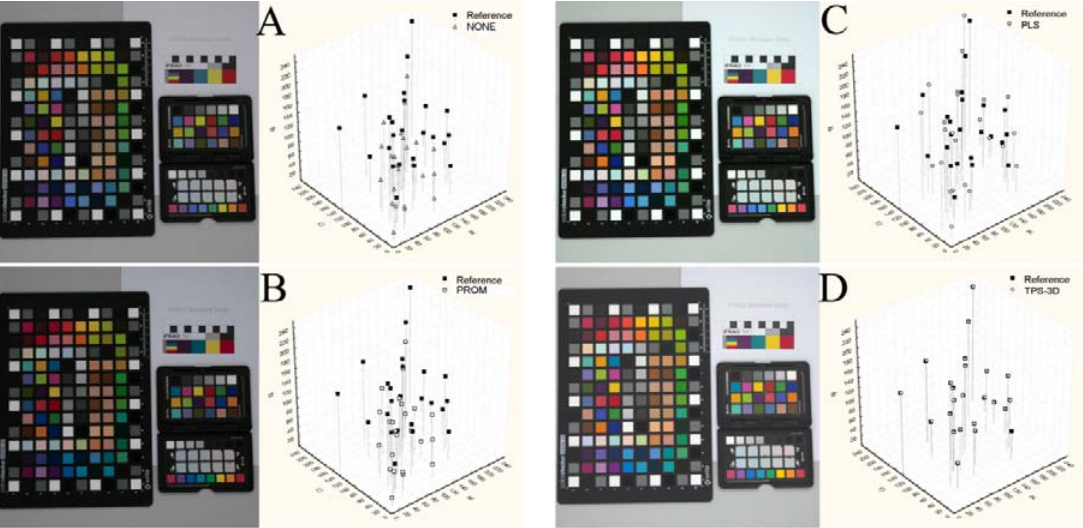
Figure 2. On the left side of the Figure, the original (NONE) image ( A ) and post-calibration with the GretagMacbeth ColorChecker 24 color-patches images ( B : PROM; C : PLS; D : TPS-3D) illuminated with 200 watt Tungsten bulbs (5,000° K). On the right side of the Figure, the correspondent reference (black squares) and pre-/post-calibration (white symbols) RGB values based on the GretagMacbeth ColorChecker 24 color-patches (within-distance —Table 1).